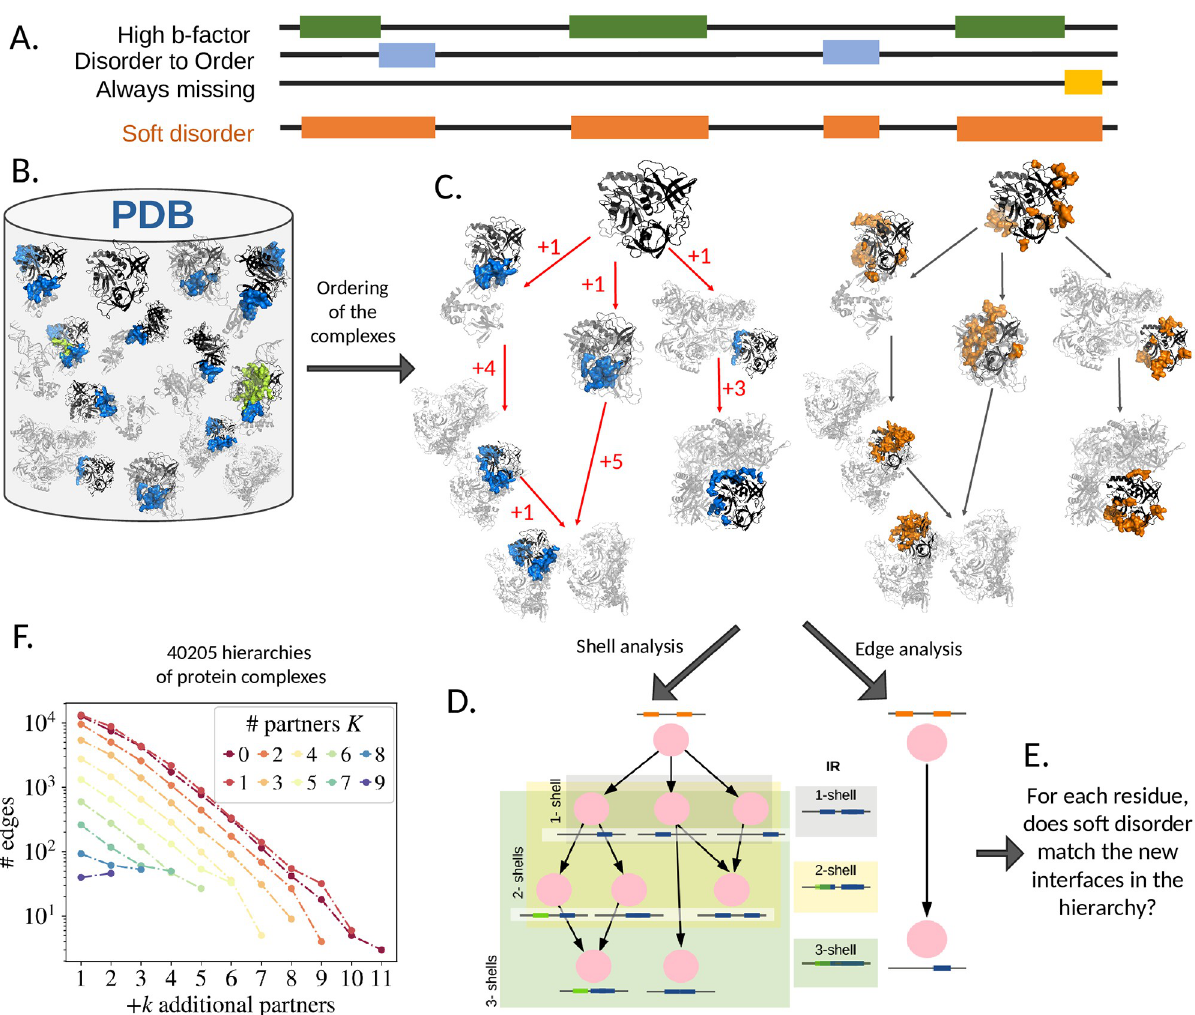
Fig 1. A. Scheme illustrating the definition of soft disorder for protein structures with the same interaction complexity, i.e. corresponding to a node in the hierarchy of assembly consisting of one or more alternative PDB crystals. Softly disordered residues are selected either for having high B-factor or for being missing in at least one of the hierarchy node’s crystals. This means that both intermittently missing/structured residues (e.g. hot loops) and always missing residues are included. B-E. Scheme illustrating the construction and analysis of a hierarchy of protein structures using a cluster of PDB structures. B. All PDB entries that have a specific or very similar chain sequence (black) are grouped in the same cluster. The partners are shown in grey and the interfaces in blue and green, depending on whether the interaction is with a protein or with DNA. C. The interactions of a protein with its partners (B) are used to construct a hierarchy of progressive assembly represented by a DAG (S1 and S2 Figs). The labels on the red edges show the number of new partners interacting with the chain in the child node compared to the parent node. On the right hand side, the soft disorder (orange) of each node is calculated as in A. D : Schematic representation of the two different tests of correlation between the soft disorder in a parent node (orange regions on a black sequence) and the interface regions in its descendants (blue or green regions on a black sequence): edge analysis compares two nodes directly connected by an edge in the graph, and shell analysis compares the soft disorder of a given node with the union of all the interfaces of the chain in the shell of its descendants. A k - shell denotes the union of all interfaces in nodes that have � k partners more than the input node of the DAG. all- shell denotes the union of all interfaces in the chain within the entire hierarchy. The union of the interface regions in each shell is sketched on the right. Each k -shell contains all the interface residues of the i -shells, with i � k . E : Our analysis aims to decide whether the soft disorder predicts new interfaces or not. F : Distribution of the total number of edges for proteins in the 40 205 hierarchies in our database containing parent nodes with K partners, where K varies from 0 (red) to 9 (blue) and K + k indicates the number of additional partners + k in the child of the edge